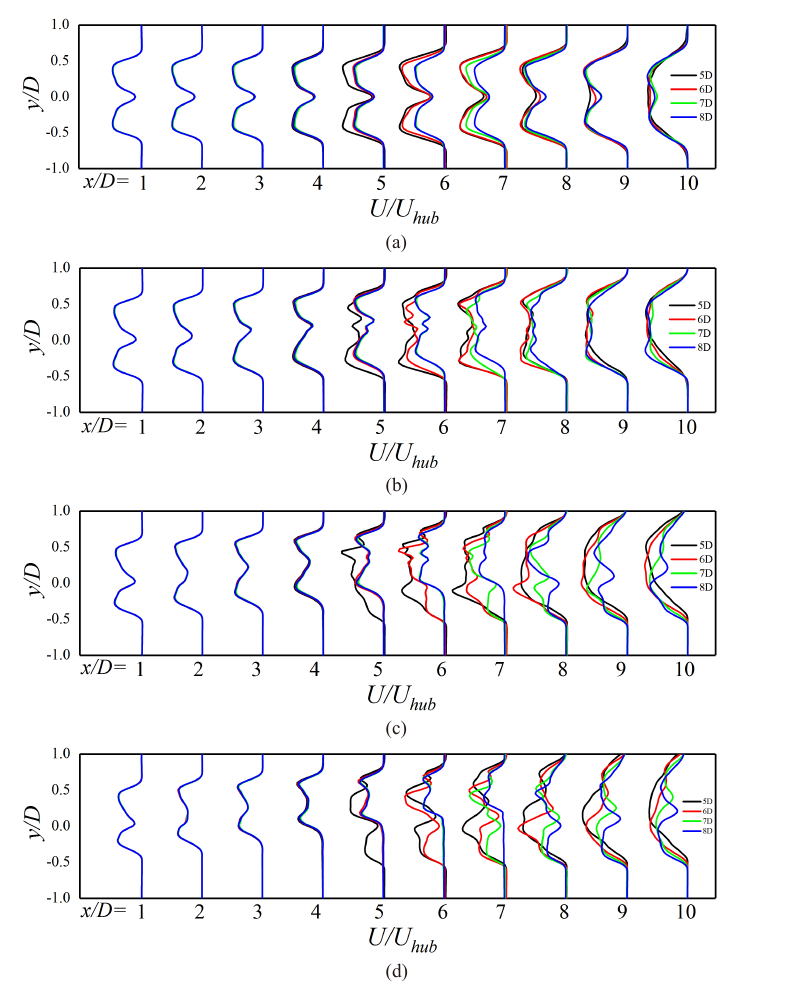
Figure 10. Time − averaged wake velocity deficit profiles normalized by the hub − height average speed of 11.4 m/s. The velocity deficit scale for each profile ranges from 0 to 1. Each consecutive profile is taken 1D downwind: ( a ) yaw = 0 ◦ ; ( b ) yaw = 10 ◦ ; ( c ) yaw = 20 ◦ ; ( d ) yaw = 30 ◦